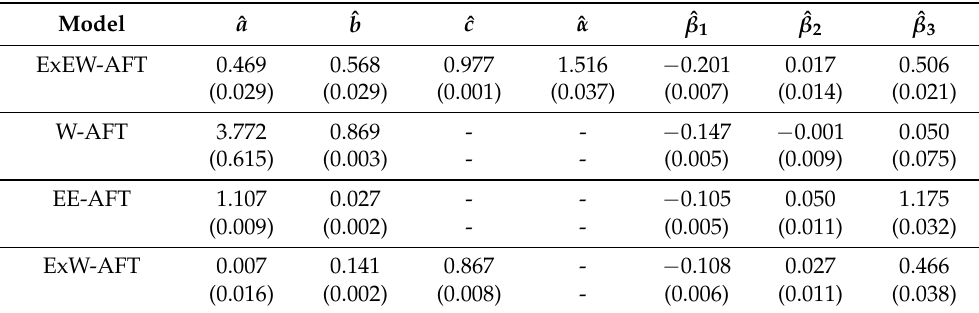
Table 21. MLE fits of the ExEW, W, EW, and ExW AFT models with SE (in parentheses) for COVID- 19 data.